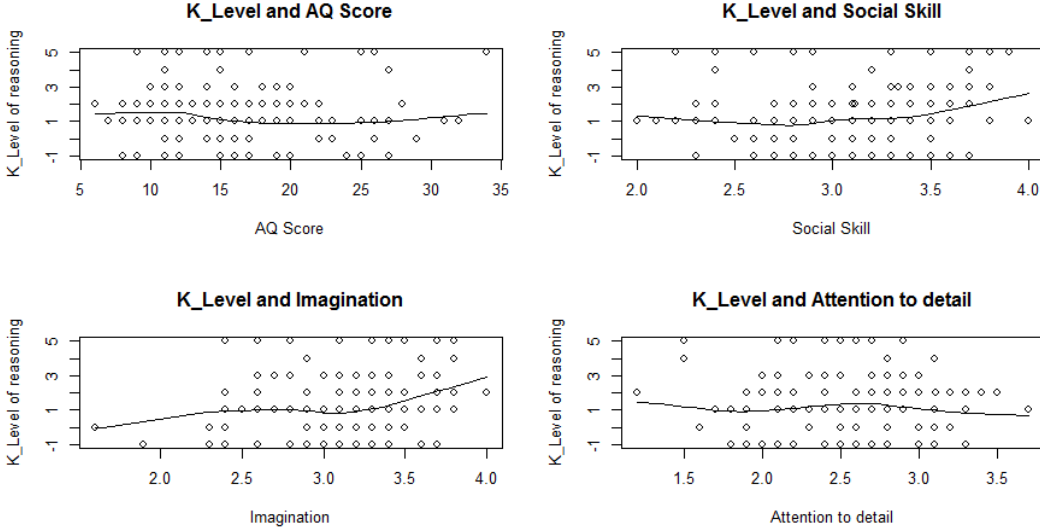
Figure 3. Scatterplots with Loess depicting level-K of reasoning as a function of AQ, social skill, imagination, and attention to detail.